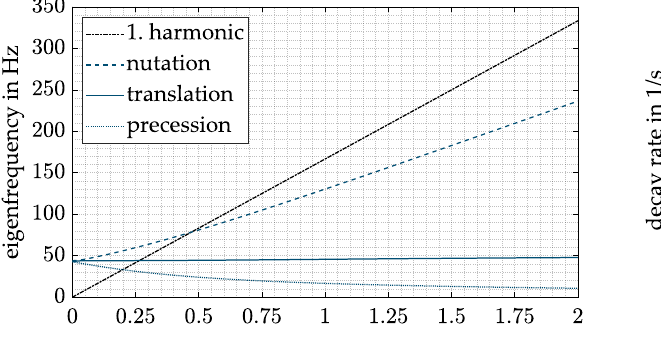
Figure 13. Extended CFC and DVFC with C att = 0.5 : ( a ) Campbell diagram; ( b ) decay rate.